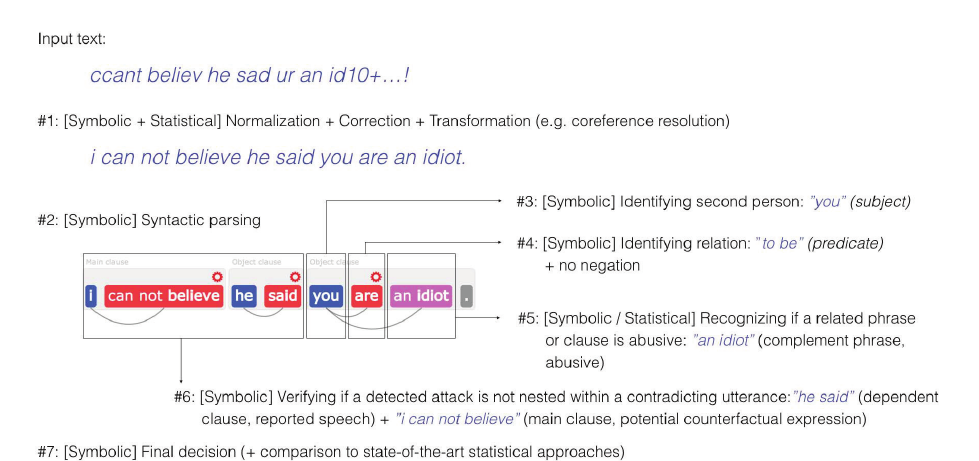
Figure 1. Example of processing of one sentence by the applied Samurai